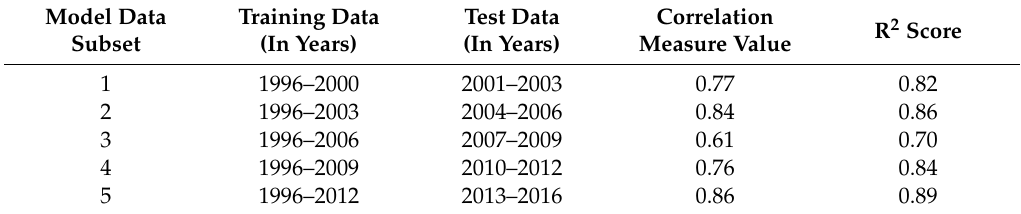
Table 2. Dataset testing with 5-fold forward chaining